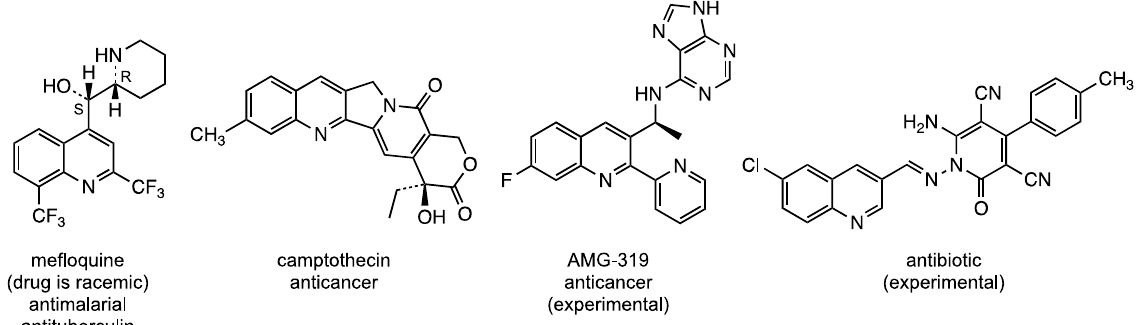
Figure 1. Established and experimental quinoline-based